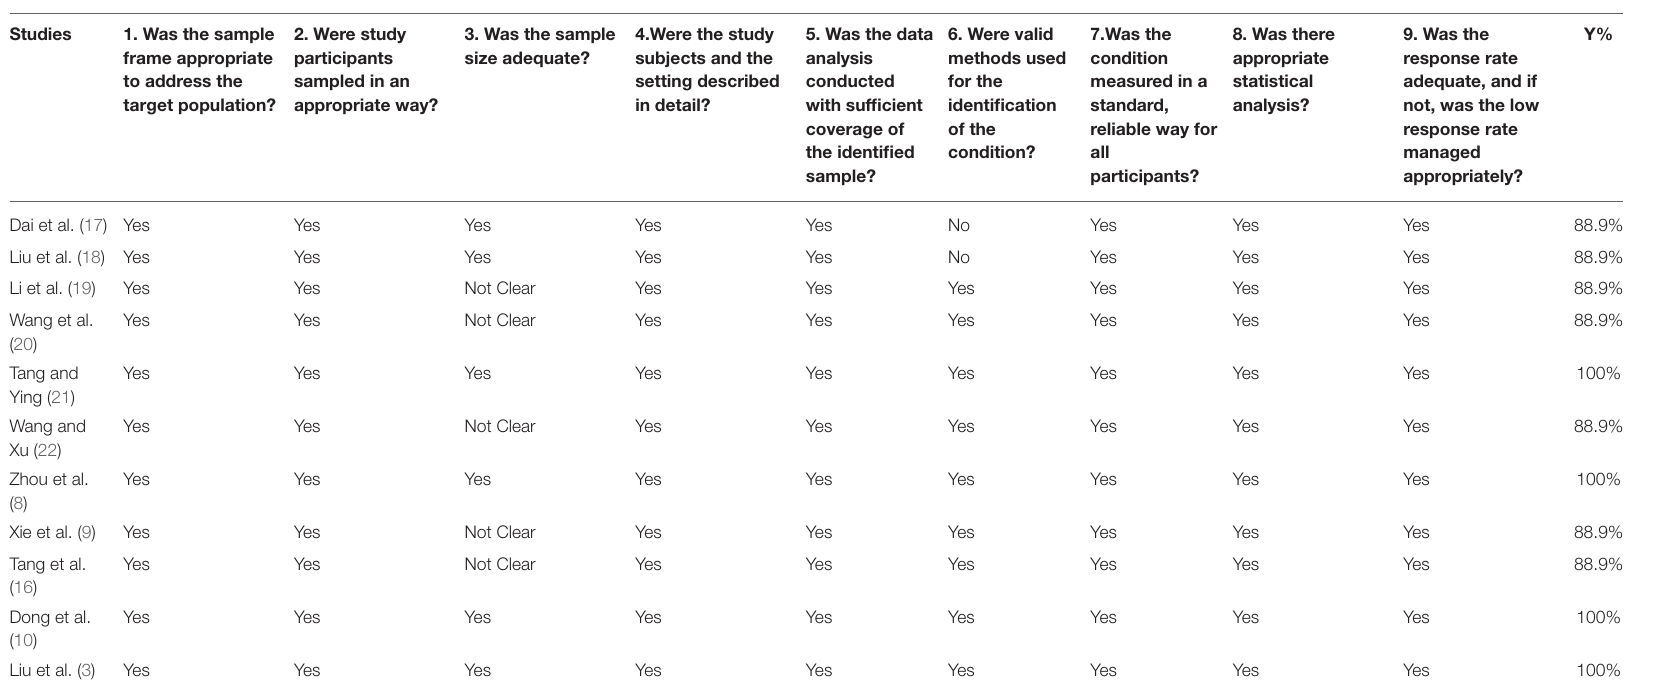
TABLE 2 | The JBI Critical Appraisal Checklist for Studies Reporting Prevalence Data.